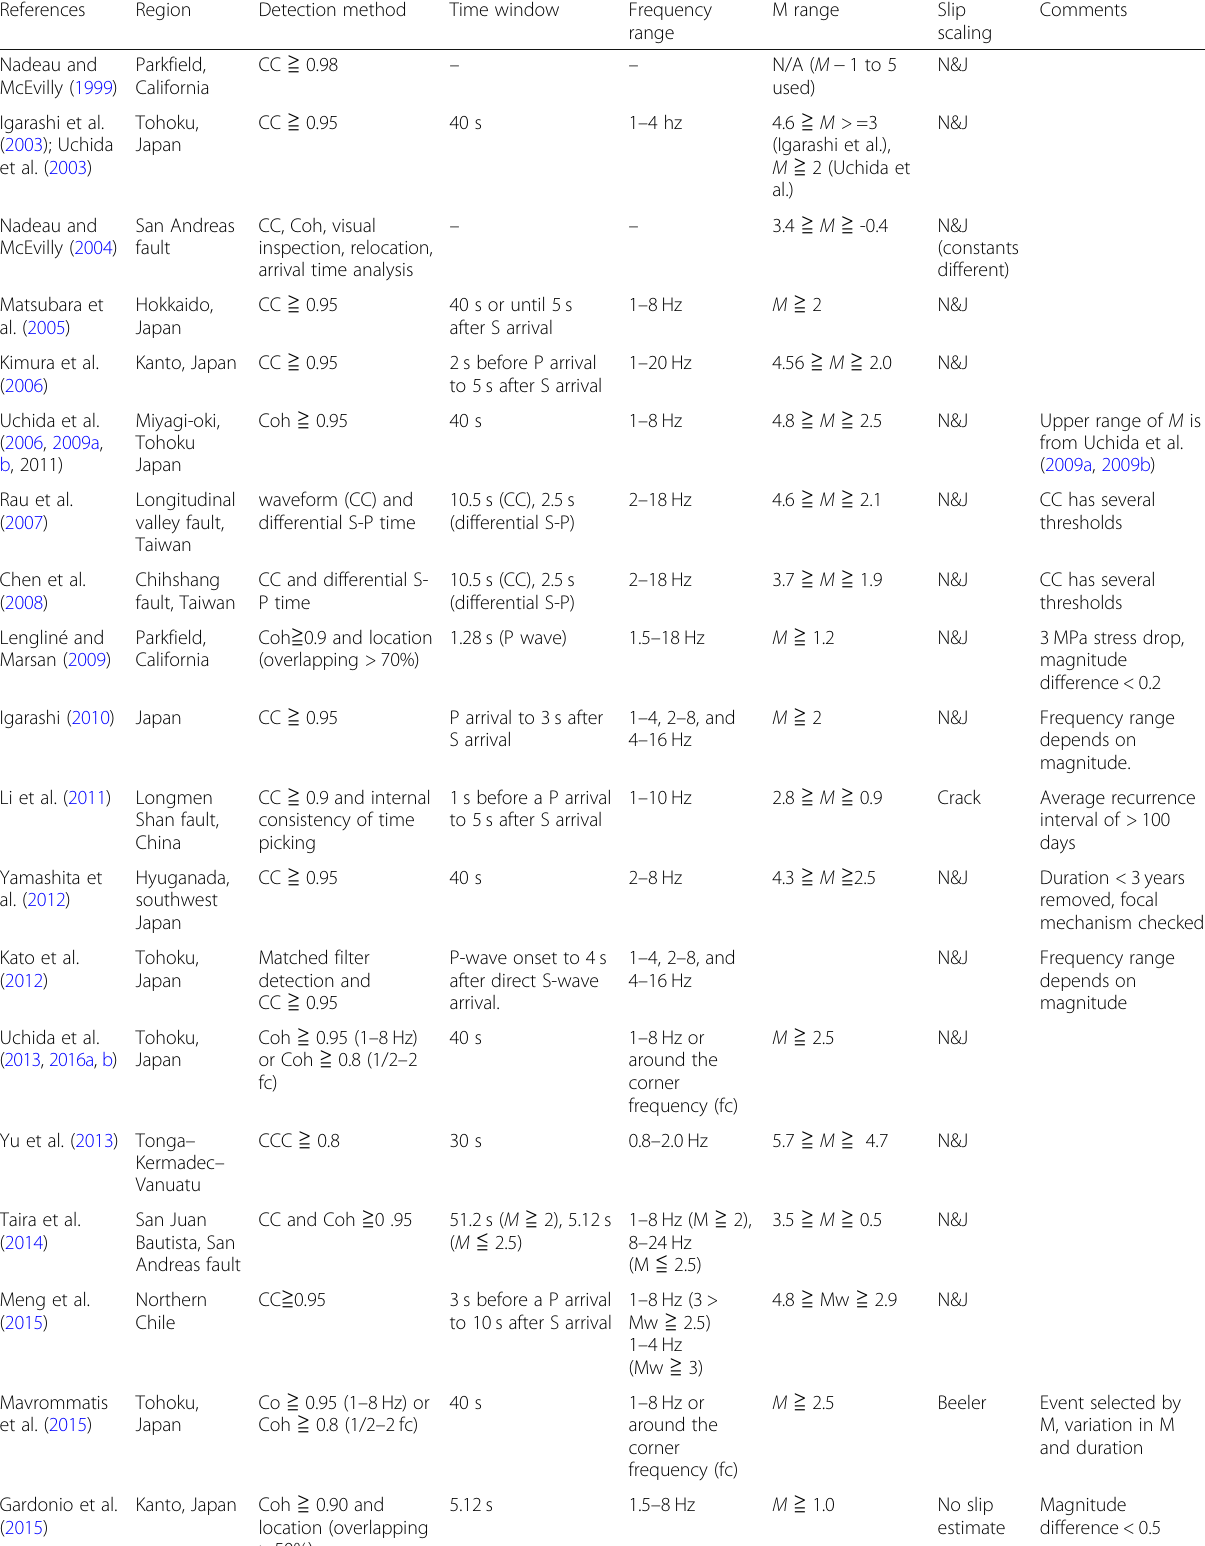
Table 1 Comparison of repeating earthquake selection and slip estimation methods for selected